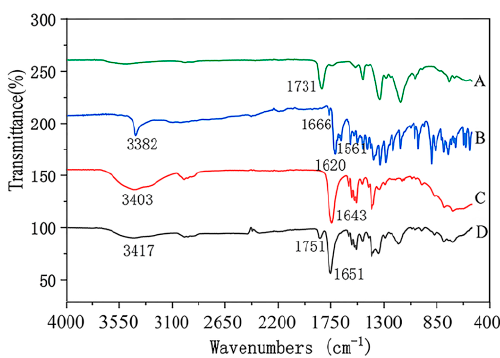
Figure 6. ATR-FTIR spectra of nanofibers and raw materials. A: CA; B: emodin; C: PVP; D: nanofibers with emodin.